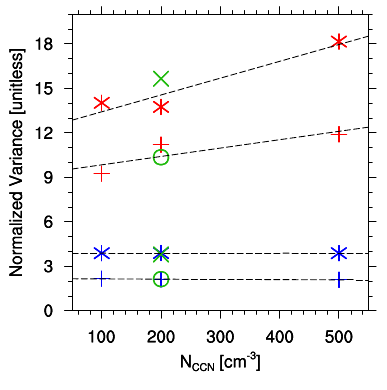
Fig. 19. Variance in the normalized cumulative precipitation for all simulations shown as a function of N CCN . Both bin (red) and bulk (blue) simulations are shown. The IN sensitivity runs are also shown (green). The lowRH scenario (stars) and highRH scenarios are depicted (pluses). The dashed lines are drawn to show any po- tential trend in the variance with changes in aerosol